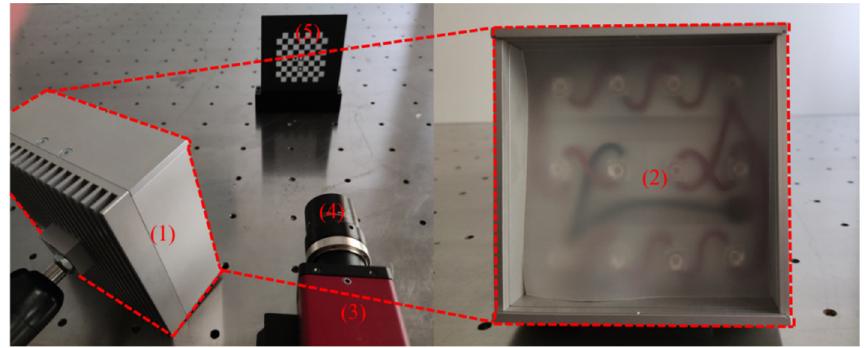
Figure 5. Experimental equipment diagram: (1) LED light array, (2) LED light front, (3) camera, (4) lens, and (5) calibration board.